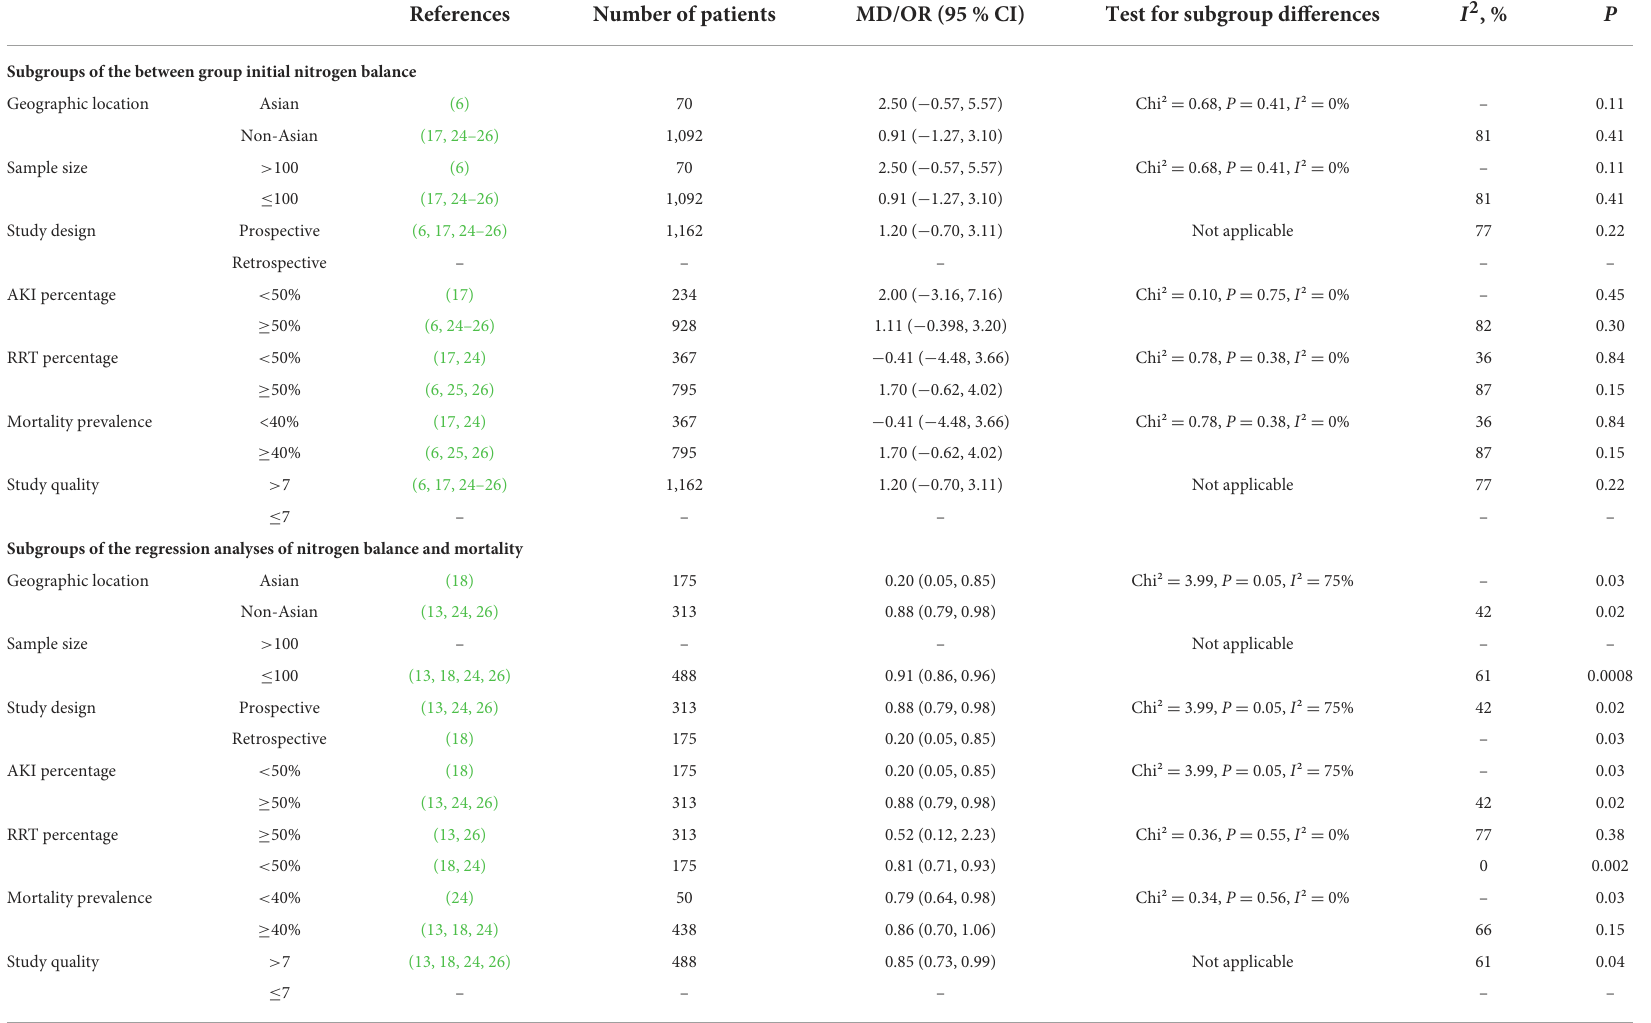
TABLE 3 Subgroup analyses of the primary outcome in the current